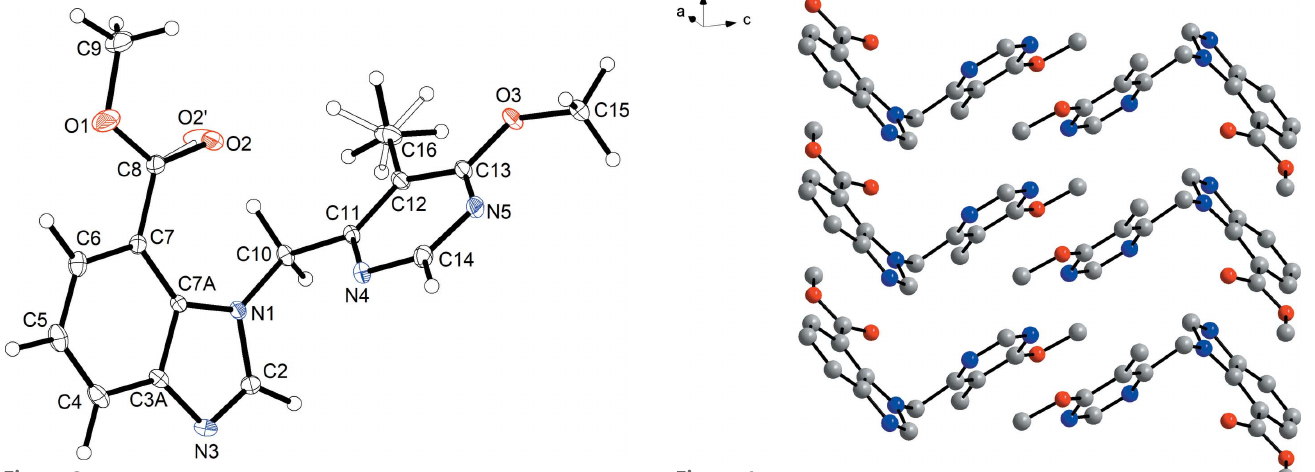
Figure 4 Section of the crystal structure of 3 . Colour scheme: carbon, grey; nitrogen, blue; oxygen, red. Hydrogen atoms and O2 0 are omitted for